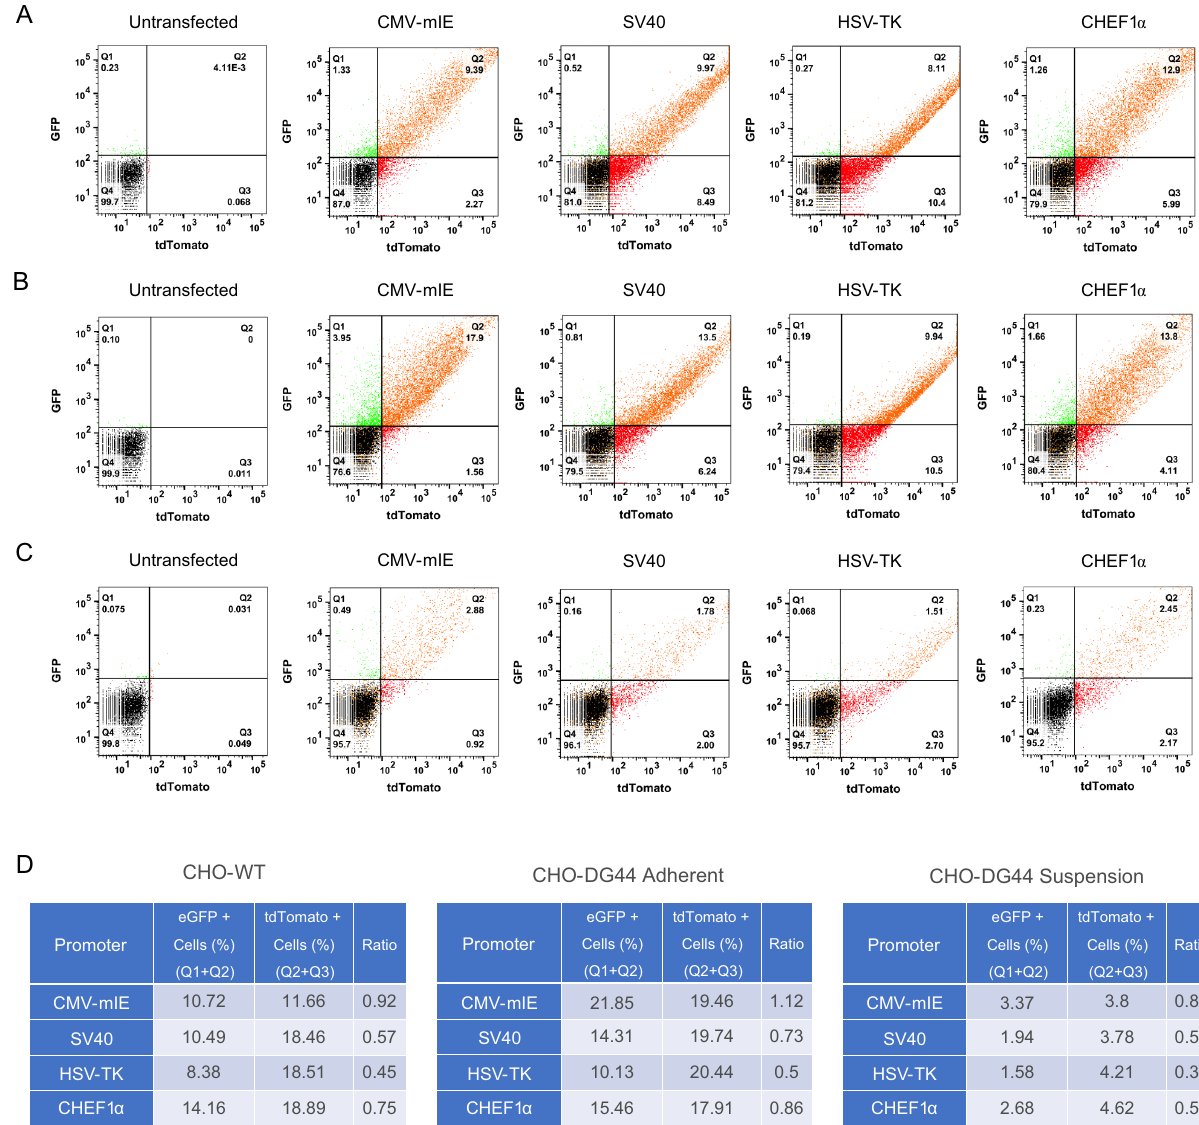
Figure 3. Cross validation of bioluminescence based results and analysis of promoter strength using the dual fluorescence reporter system in transient expression settings. Promoter strength was investigated by flow cytometry to verify bioluminescence based analyses while also demonstrating that the reporter system can function with fluorescence signals. The vector panel carrying CMV-mIE, SV40, HSV-TK and CHEF1α promoters was transiently transfected into CHO cell variants. At 48 h post-transfection, flow cytometry was conducted to evaluate promoter activities on ( A ) CHO-WT, ( B ) CHO-DG44 adherent and ( C ) CHO-DG44 suspension cells. ( D ) Similar to the dual luciferase reporter system, the ratio of eGFP/tdTomato fluorescence signals provides a systematic and quantitative comparison of the promoters. The strength of each promoter was expressed as the ratio of eGFP positive cells (Q1 + Q2) divided by the percentage of tdTomato positive cells (Q2 +